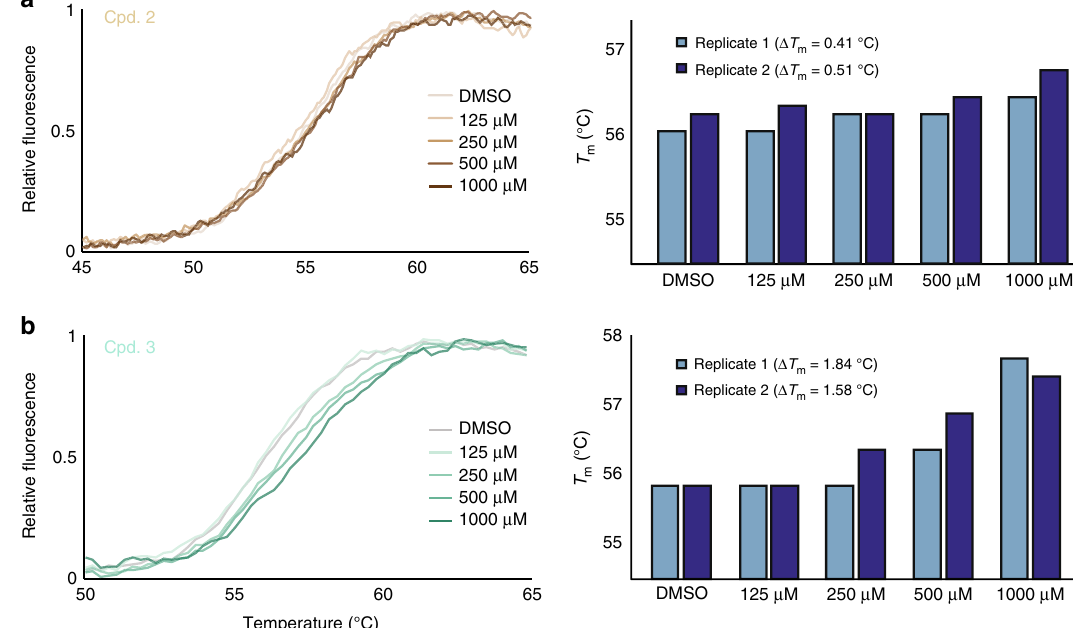
Fig. 2 Thermal shifts indicate dose-dependent stabilization of TRAF2 by compounds 2 and 3. Normalized melt curves (left) and melting temperature ( Δ T m ; right) of full-length TRAF2 were recorded in the presence of dimethyl sulfoxide or indicated concentrations of a compound 2 (tan lines) and b compound 3 (teal lines). The rightward shift of the melt curve in the presence of compounds, quanti fi ed by the Δ T m in two replicate experiments, suggest increased thermal stability of the protein – compound complex. Source data are provided as a Source Data fi